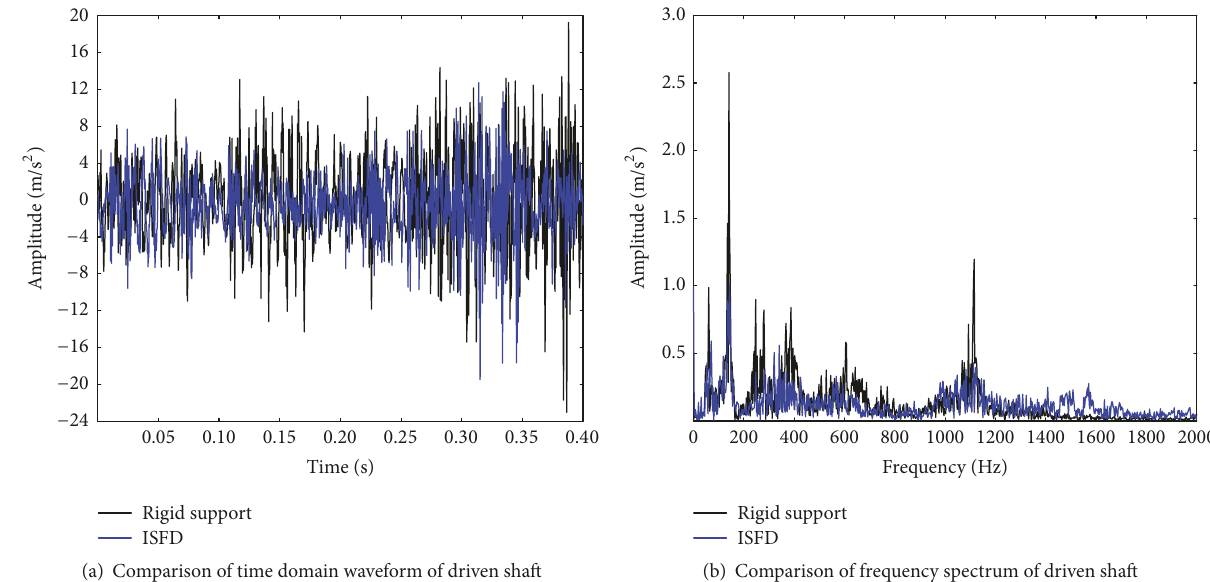
Figure 10: Comparison of vibration of driven shaft measuring point.